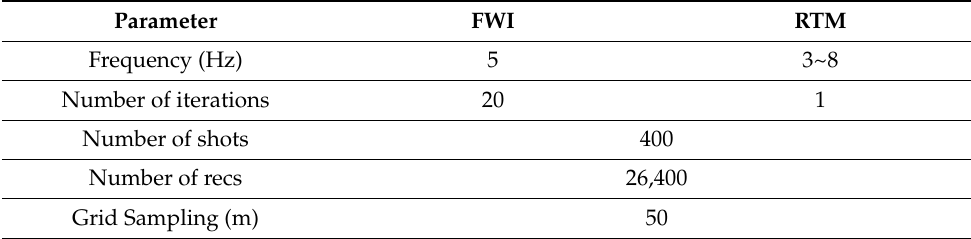
Table 1. Parameter information for FWI and RTM.